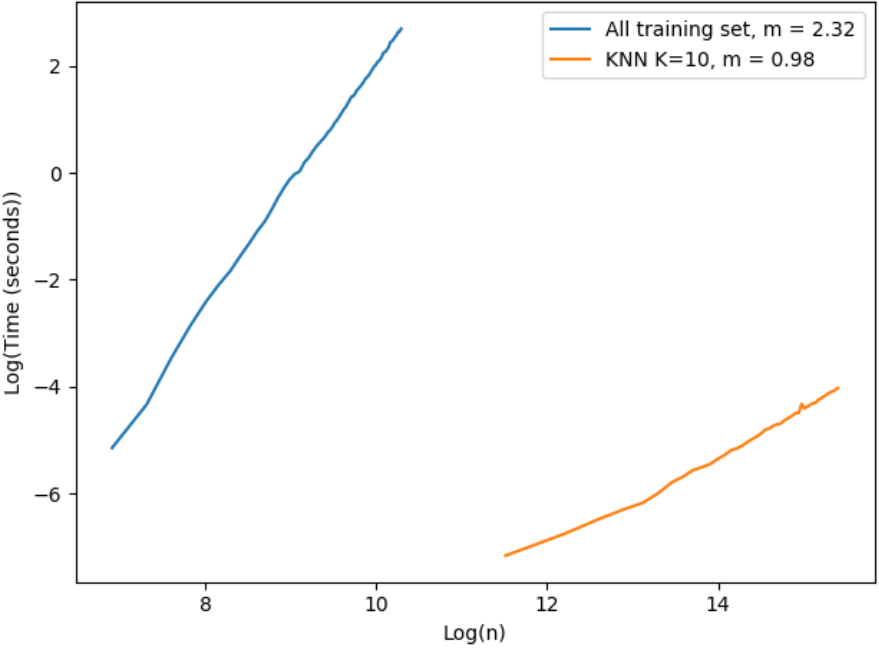
Figure 2. Time complexity single